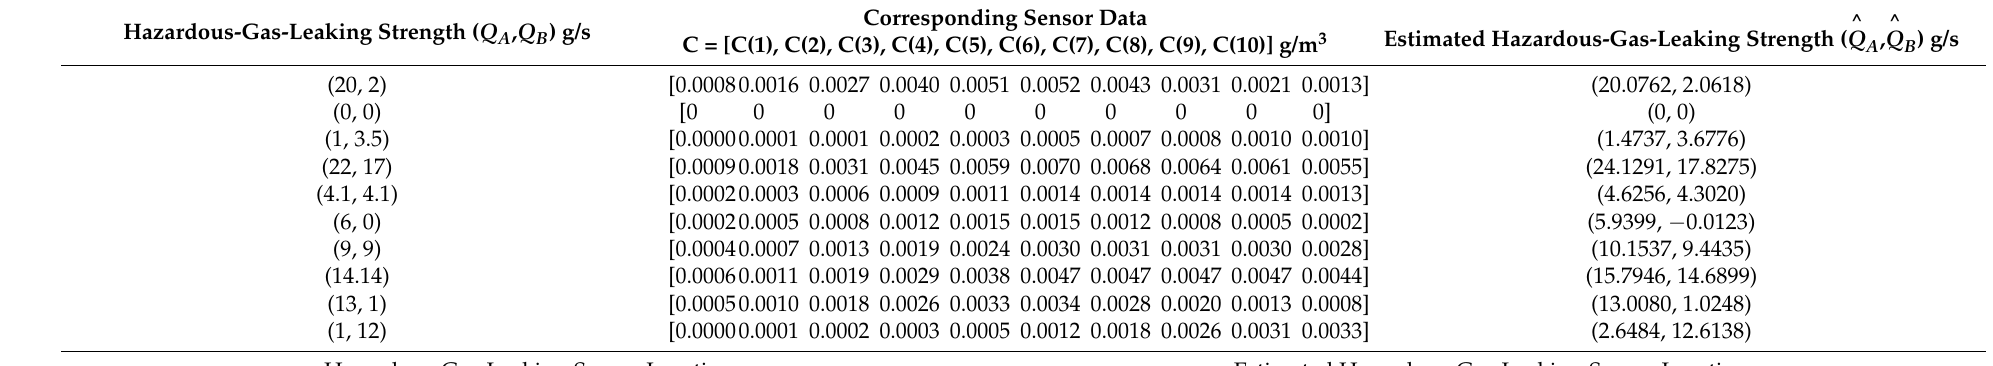
Table 5. Online STE results obtained in Step